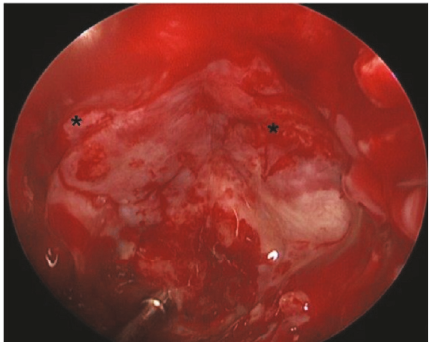
Figure 4: Sphenoidal sinus opened and demucosalized. Suction cannula is in clival recess. Black asterisks show lateral opticocarotid recessbetweencarotidartery(downward)andopticnerve(upward). Observe the short intercarotid distance and the absence of promi- nence of the sellar